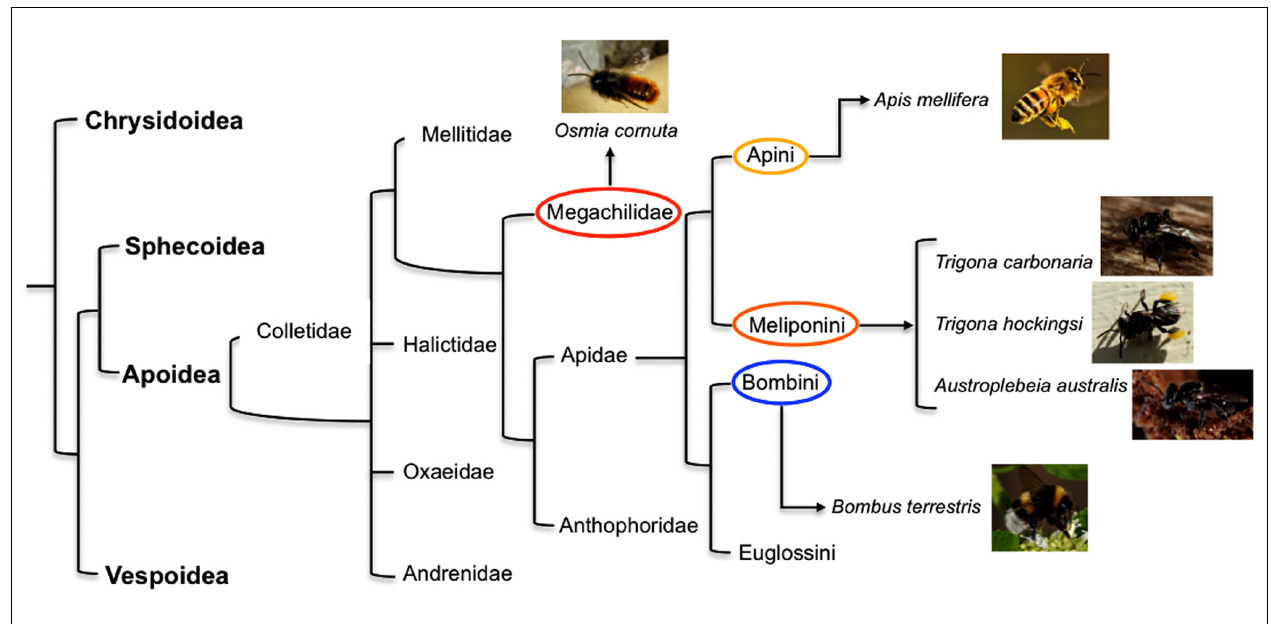
investigated for behavioral and brain asymmetries described in the current paper belong: in red the family Megachilidae (mason bee Osmia cornuta ), in yellow Apini (honeybee Apis mellifera ), in orange Meliponini (stingless bees Trigona carbonaria , Trigona hockingsi , Austroplebeia australis ), and in blue Bombini (bumble bee Bombus terrestris